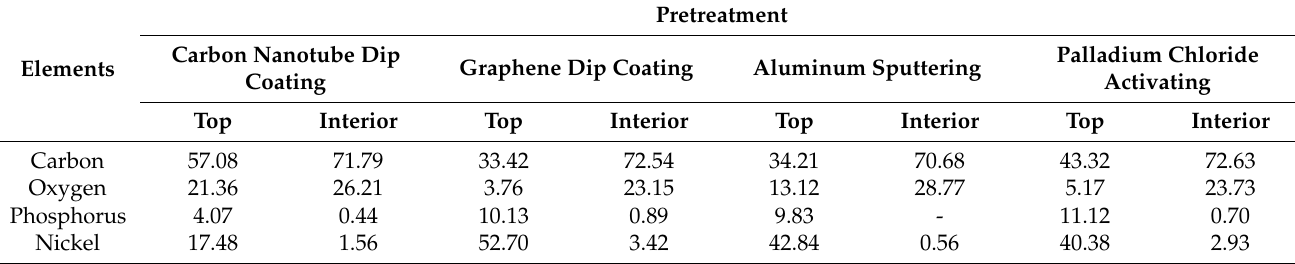
Table 3. Atomic % of element detected from energy dispersive spectroscopy